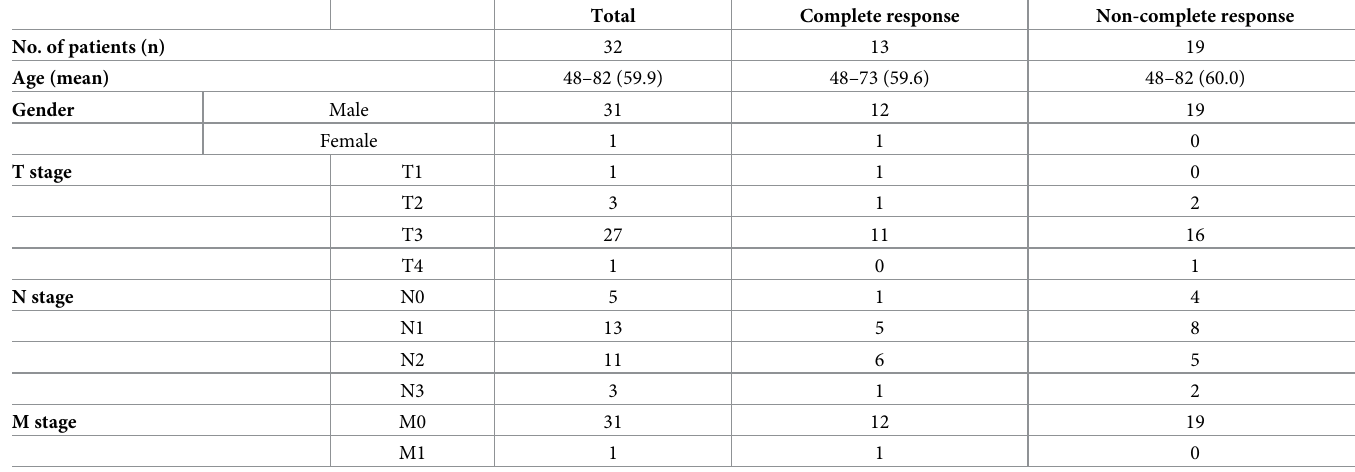
Table 1. Clinicopathological characteristics of 32 patients with esophageal cancer before neoadjuvant chemoradiotherapy.